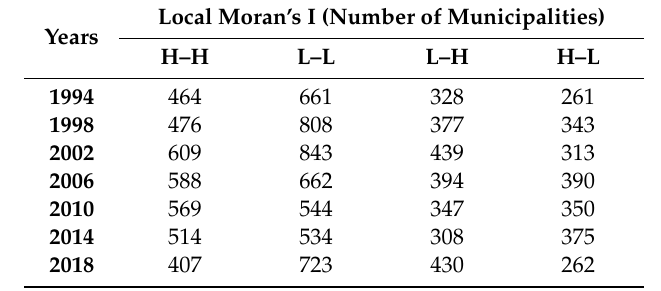
Table 2. Clustering statistics of global and local Moran’s I for women’s descriptive representation in Czech local councils,